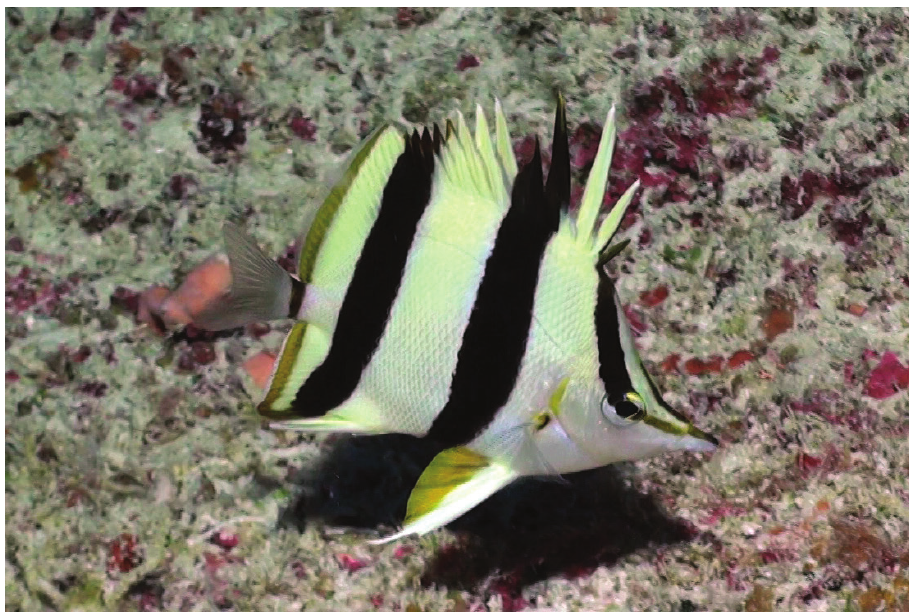
Figure 4. Prognathodes basabei at a depth of 90 m off Pearl and Hermes Atoll, Northwestern Hawaiian Islands. Photo by R. L. Pyle.